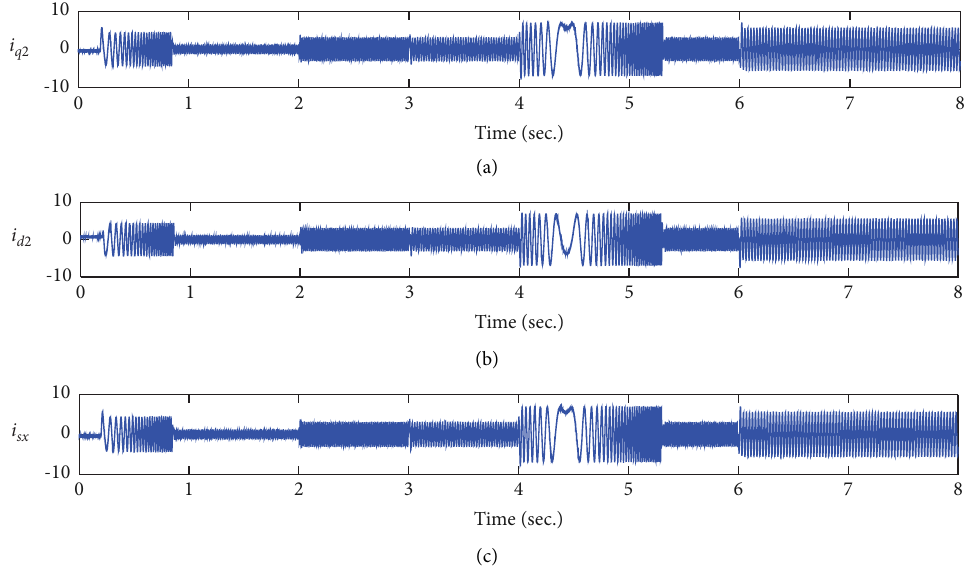
Figure 8: Resultant current fowing in winding set X